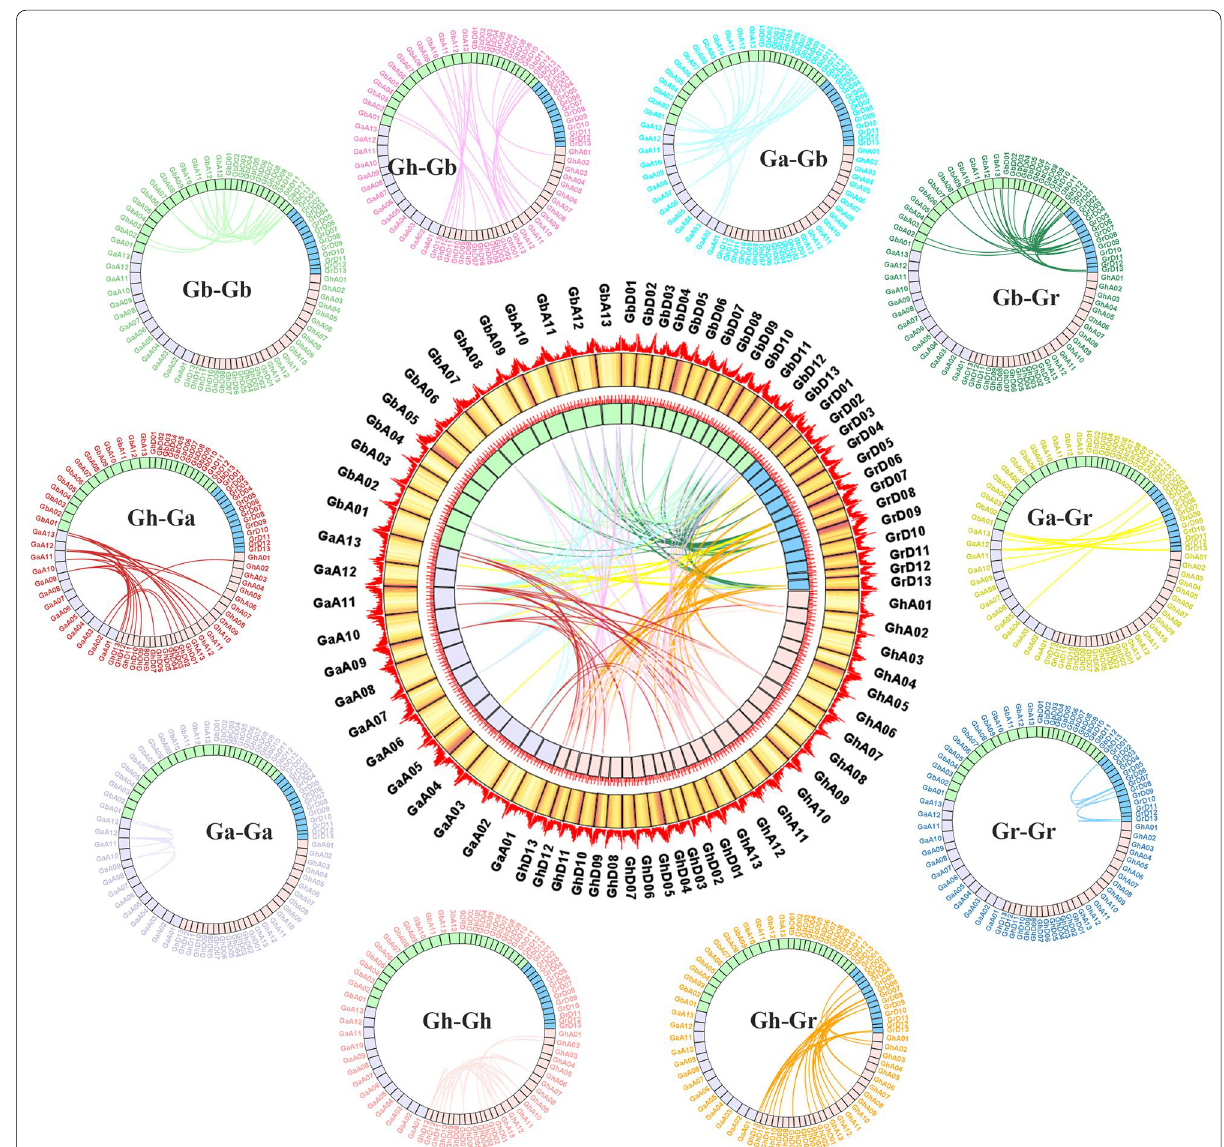
Fig. 3 Syntenic relationship of duplicated genes pairs from four Gossypium species ( G. hirsutum , G. barbadense , G. arboreum , and G. raimondii ). Chromosomal lines represented by various colors indicates the syntenic regions around the CNX